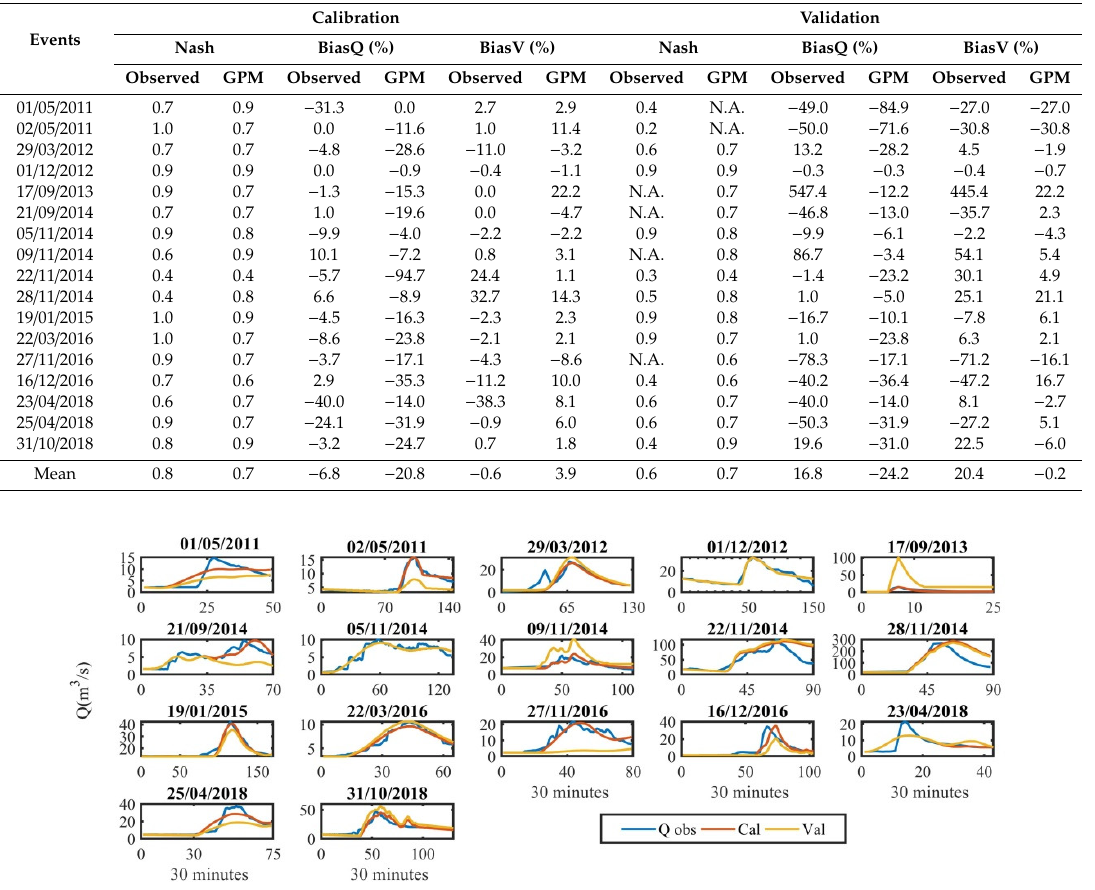
Figure 2. Floods simulated with observed precipitation.